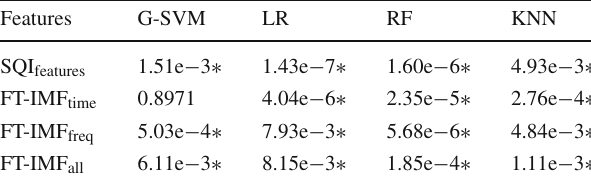
Table8 The p values of AUC between DI-Transformer and traditional methods by using different features Features G-SVM